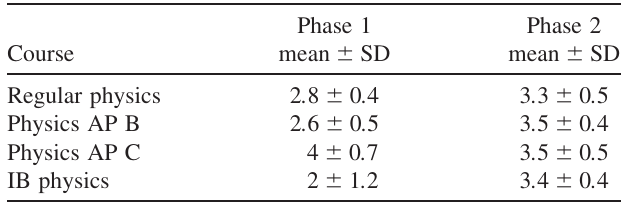
TABLE VI. Effects of prior physics classes.